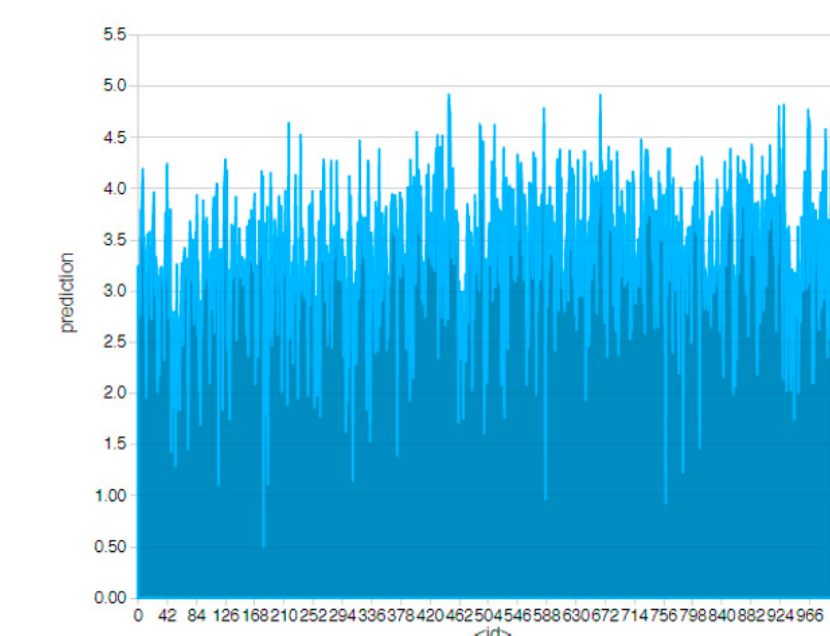
Figure 10. Graphical representation of the 1000 predictions.